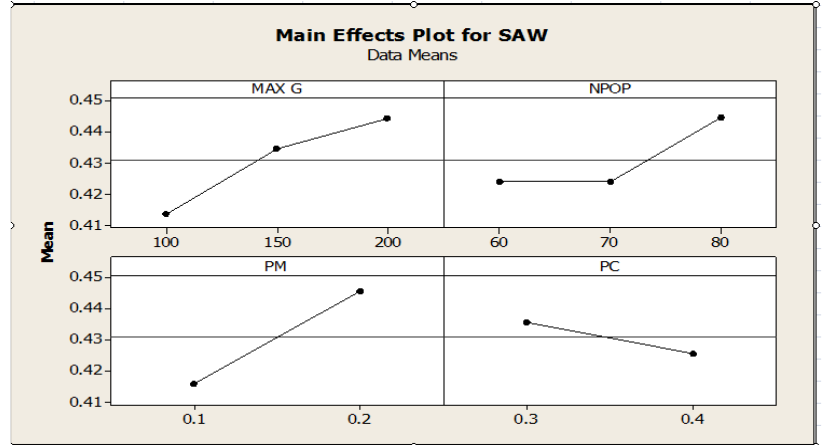
Fig. 4. Minitab software output to determine the parameter of the NSGA-II